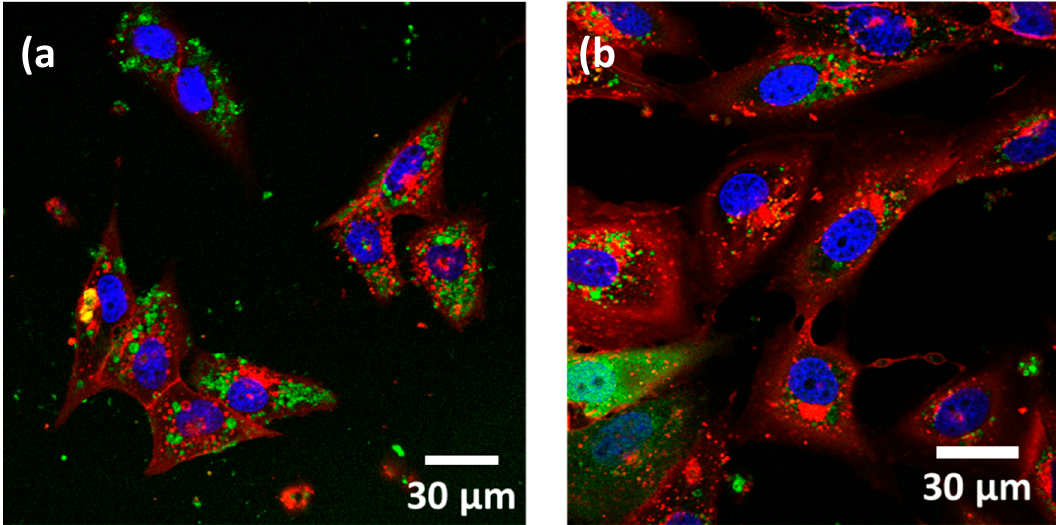
Figure 2. Fluorescence images of ( a ) Ni MNWs and ( b ) Fe 3 O 4 NRs inside OSCA-8 cells.